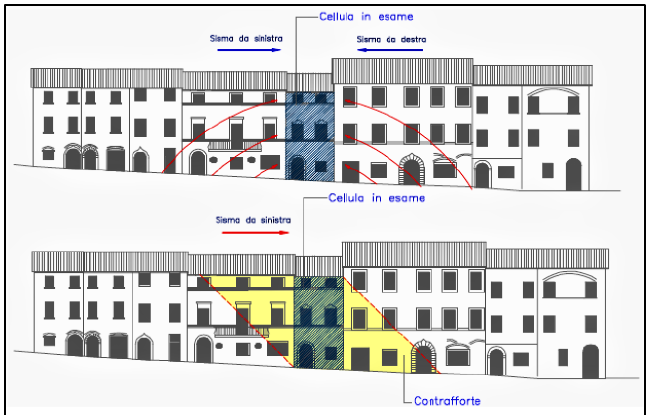
Figure 12. Hammering from adjacent building [12]. Figure 12. Stone wall with two sides.